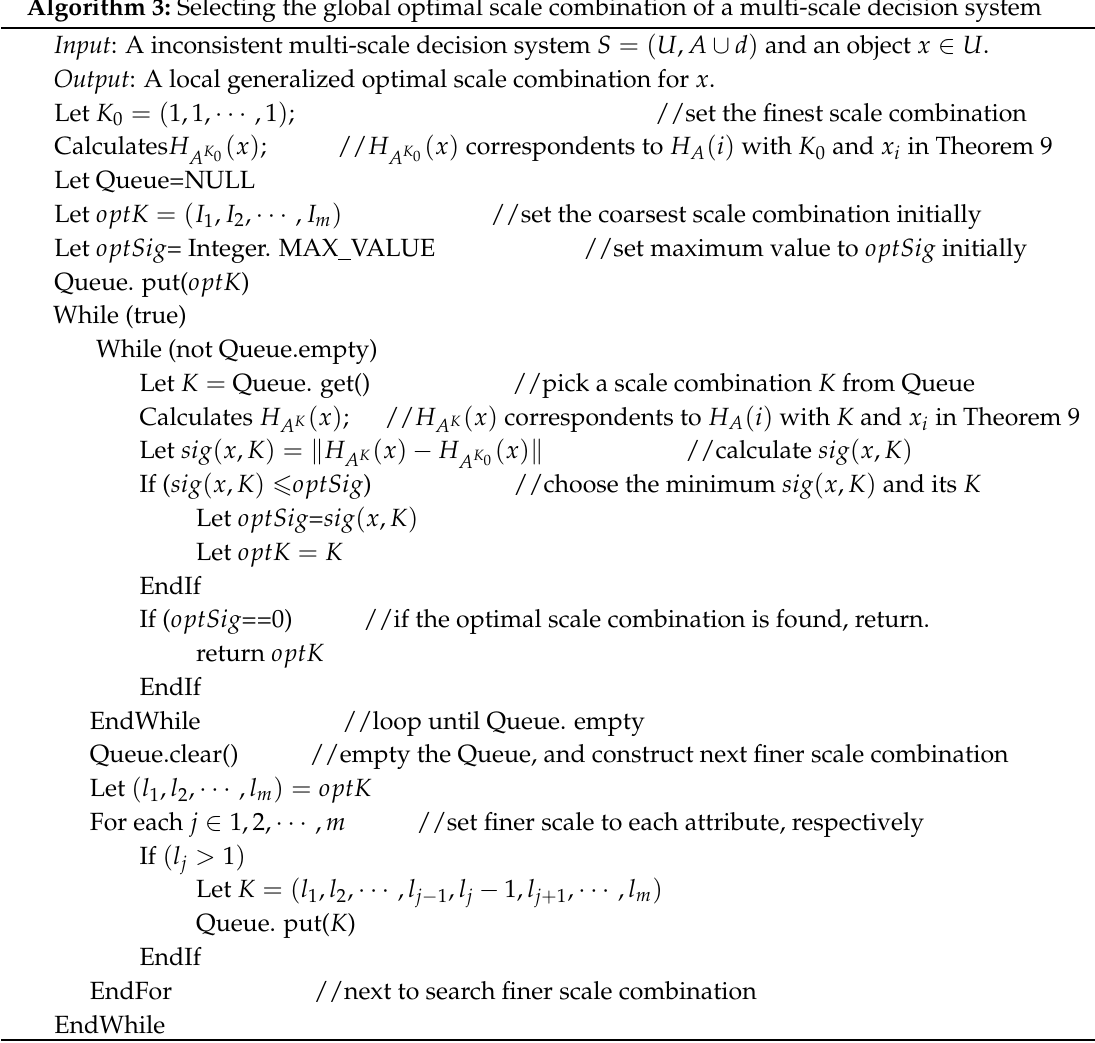
Algorithm 3: Selecting the global optimal scale combination of a multi-scale decision system